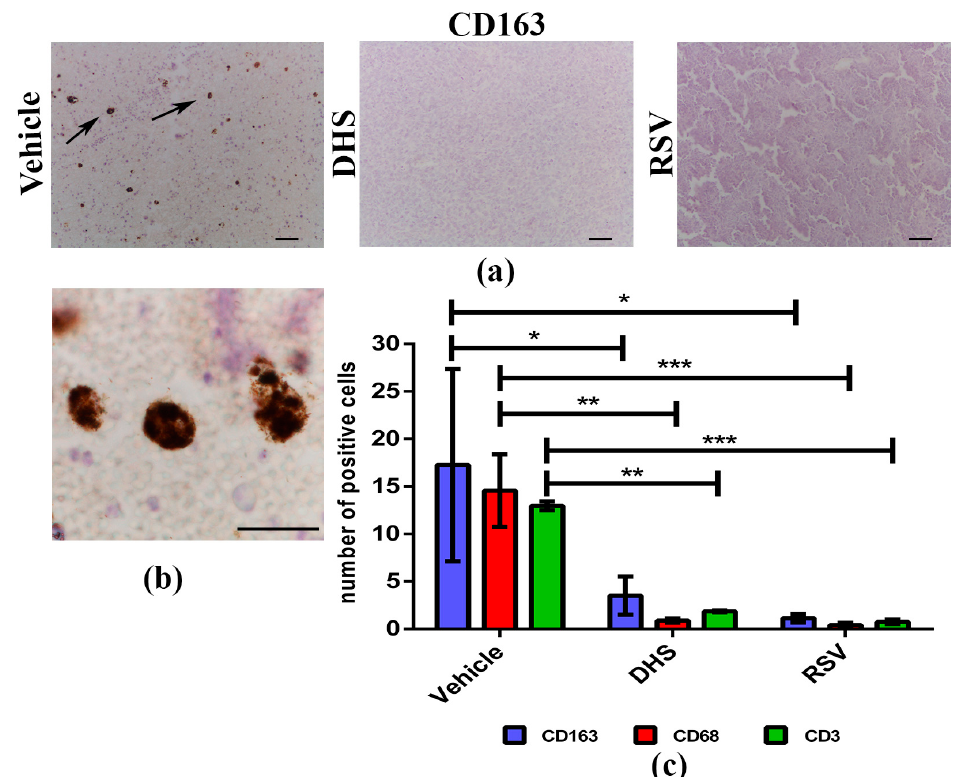
Figure 4. ( a , b ) Representative images of CD163 immunostaining in vehicle, DHS, and RSV tumour masses (scale bars = 100 μ m; 20× magnification ( a )) and in vehicle sample (scale bar 50 μ m; 100× magnification ( b )); ( c ) Quantitative analysis of CD163, CD68 and CD3 positive cells/sample (* p < 0.05; ** p < 0.01; *** p < 0.001).